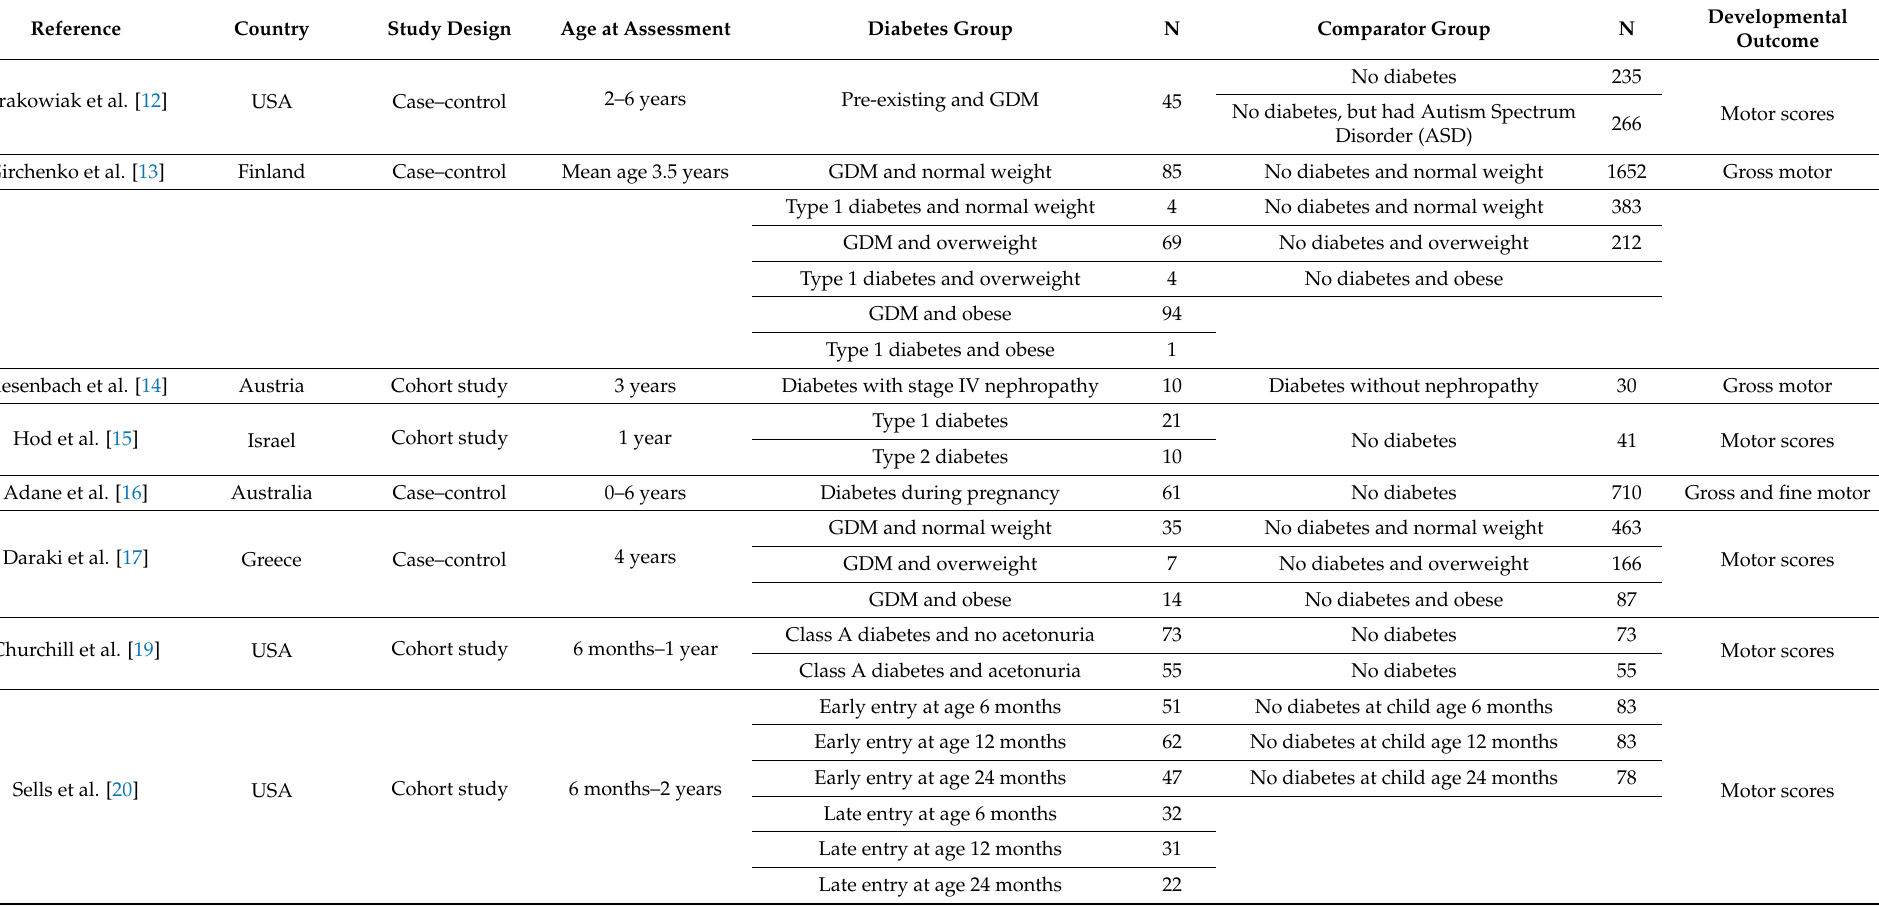
Table 1. Characteristics of included